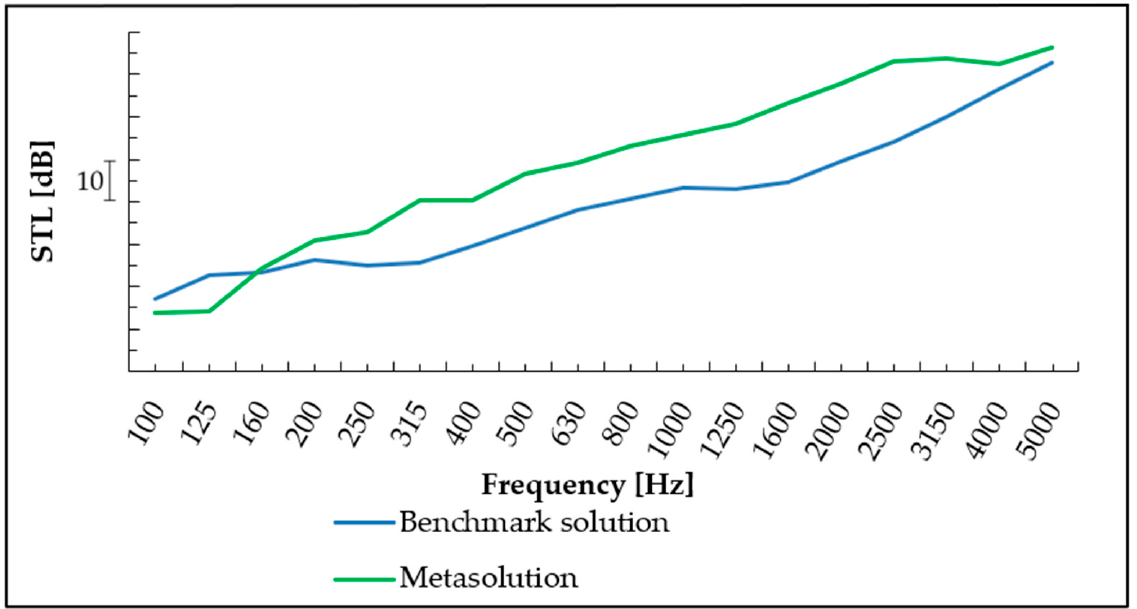
Figure 10. Metasolution vs. benchmark solution experimental STLs.